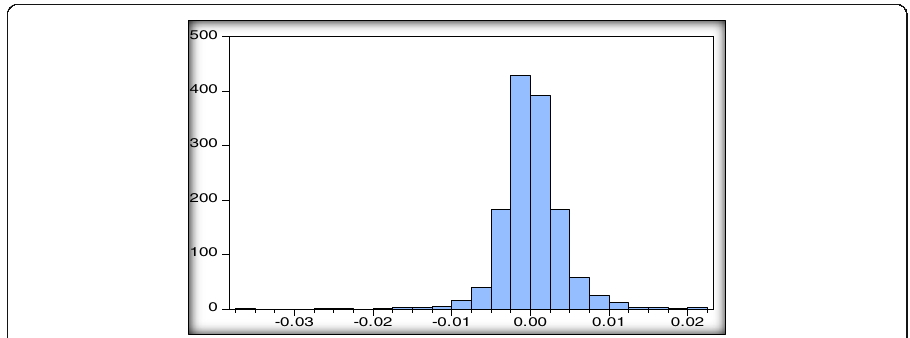
Fig. 5 Histogram representing the difference in log price of UTI GETF. LEGEND: In the histogram, the horizontal axis represents the difference in log price and the vertical axis represents the number of times each value occurs, i.e.: it is the probability density function of the difference in log price of UTI